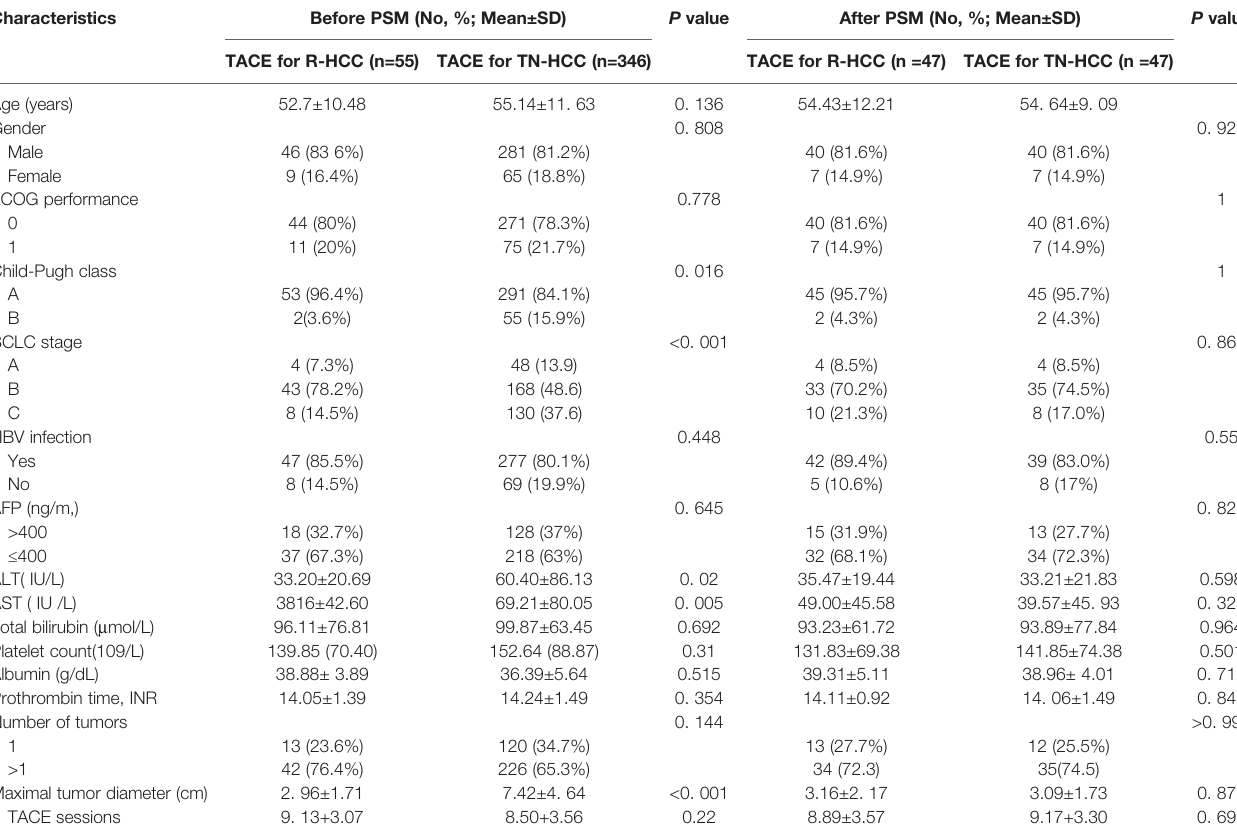
TABLE 1 | Baseline characteristics of patients between the two groups before and after PSM analysis. Characteristics